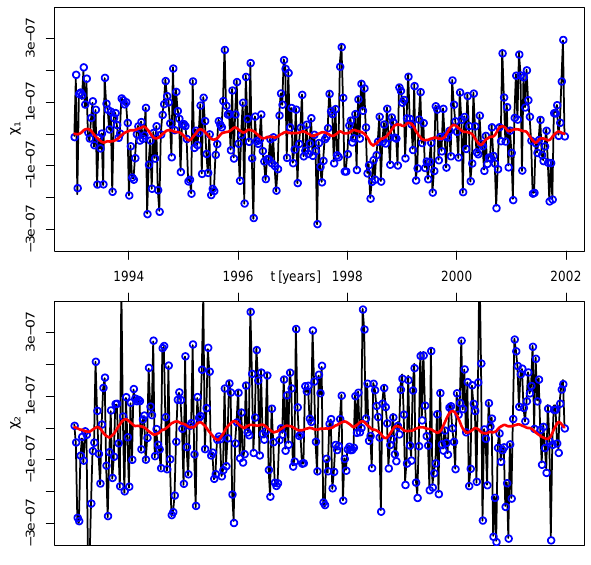
Fig. 1. Equatorial oceanic angular momentum functions. Reference-simulation (red line). Assimilation-simulation (blue dots). OAM observations (black